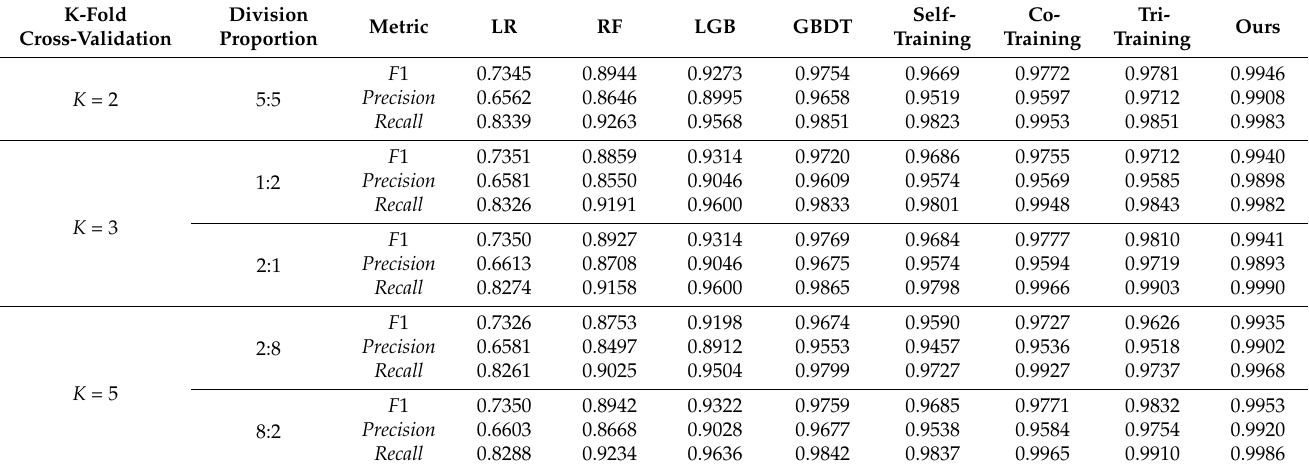
Table 2. Comparison of the results of various models on the edX dataset.